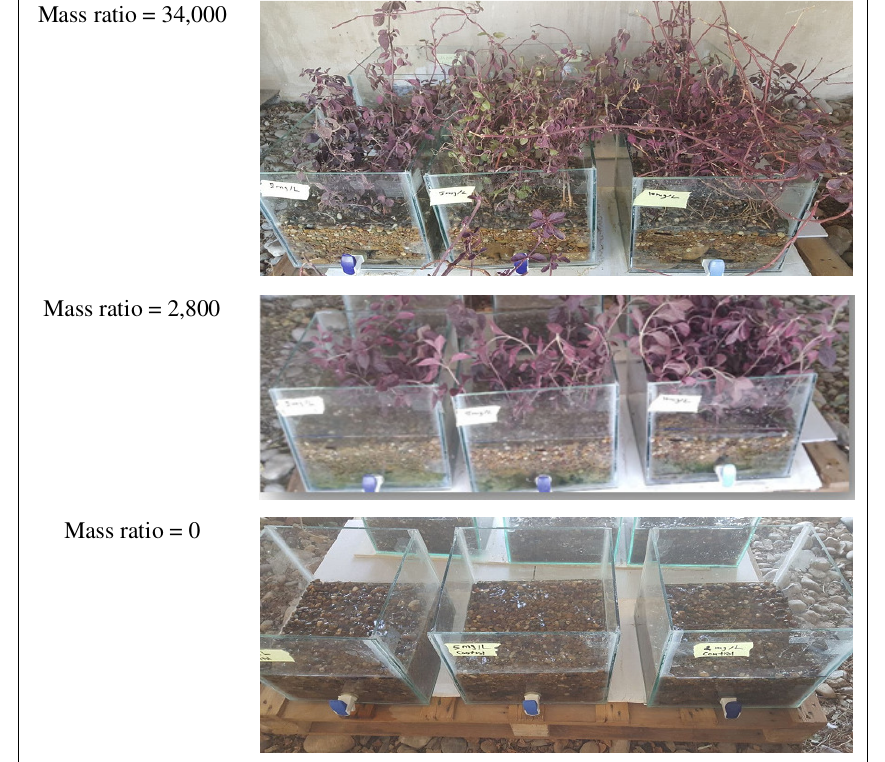
Fig. 2. Sub-surface batch system